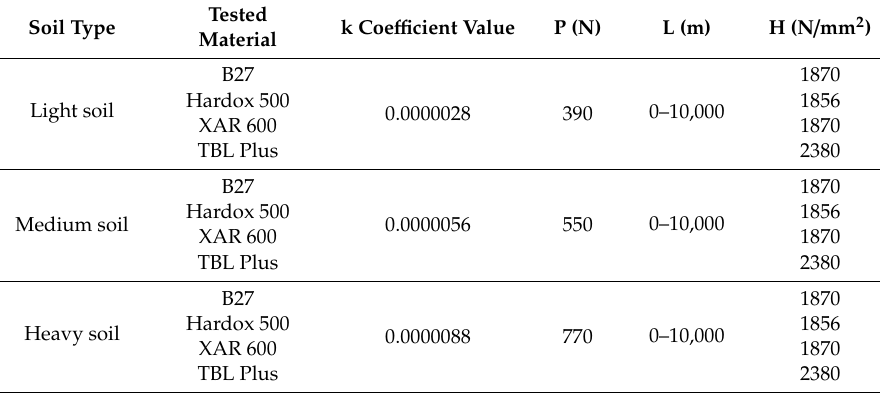
Table 3. Data adopted for the model.